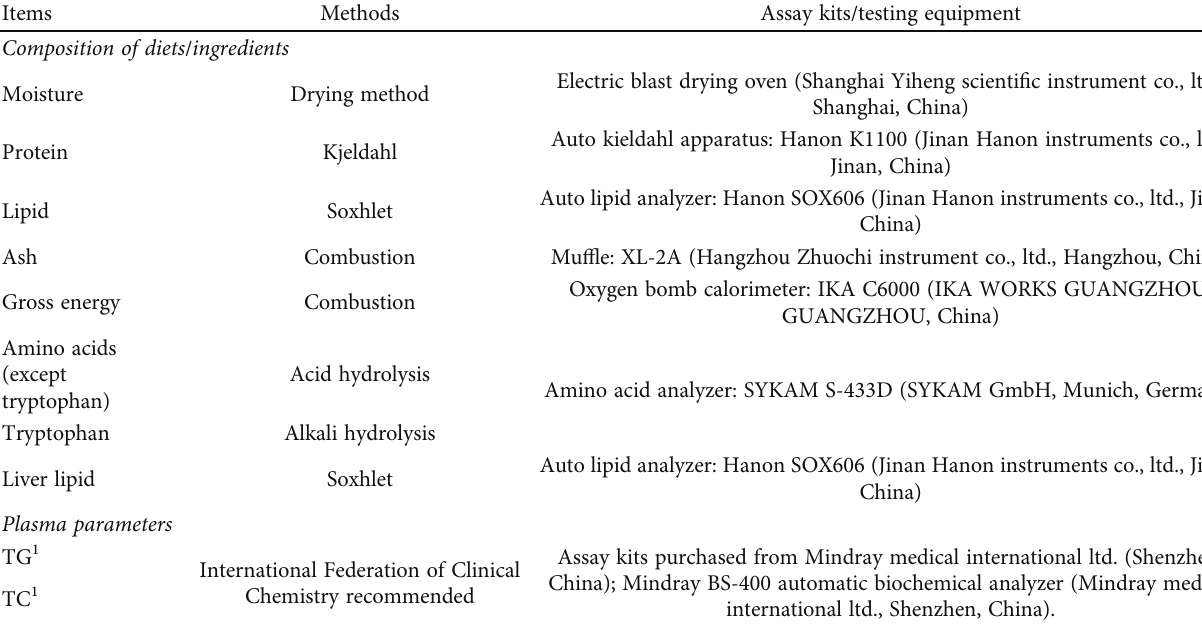
Table 3: The chemical analysis used in the